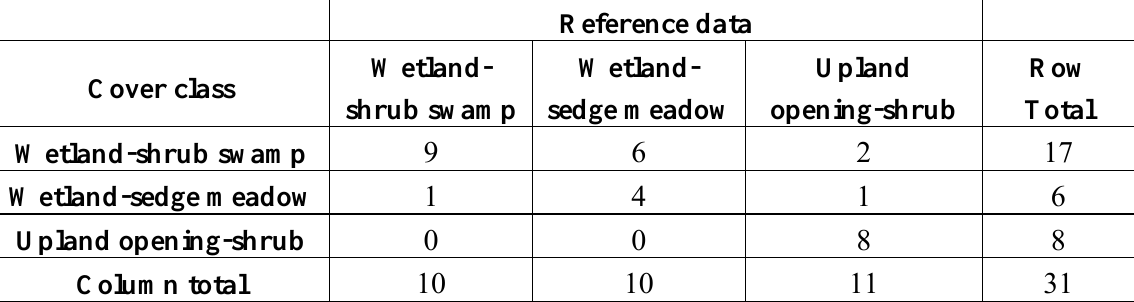
Table 4B. Another sample of classification results in the error matrix of the uncorrected image (image 2) for Nicolet vegetation